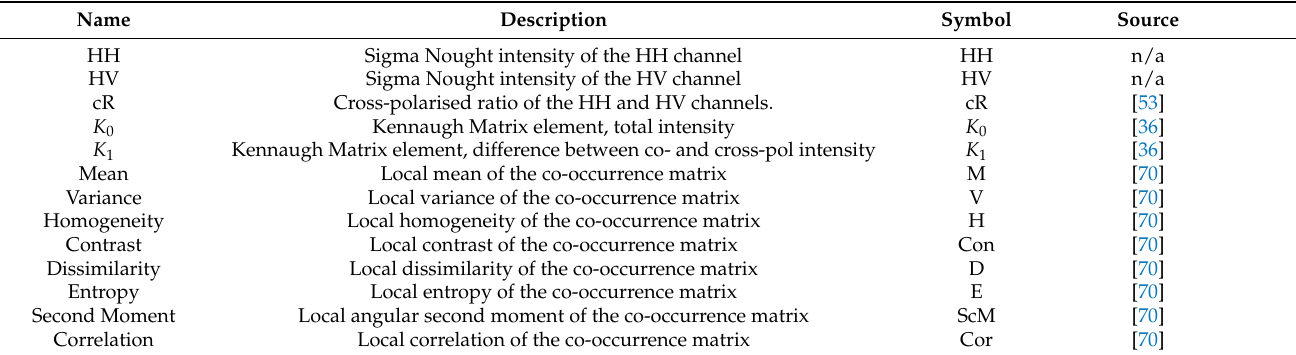
Table 3. Polarimetric and texture predictor variables.